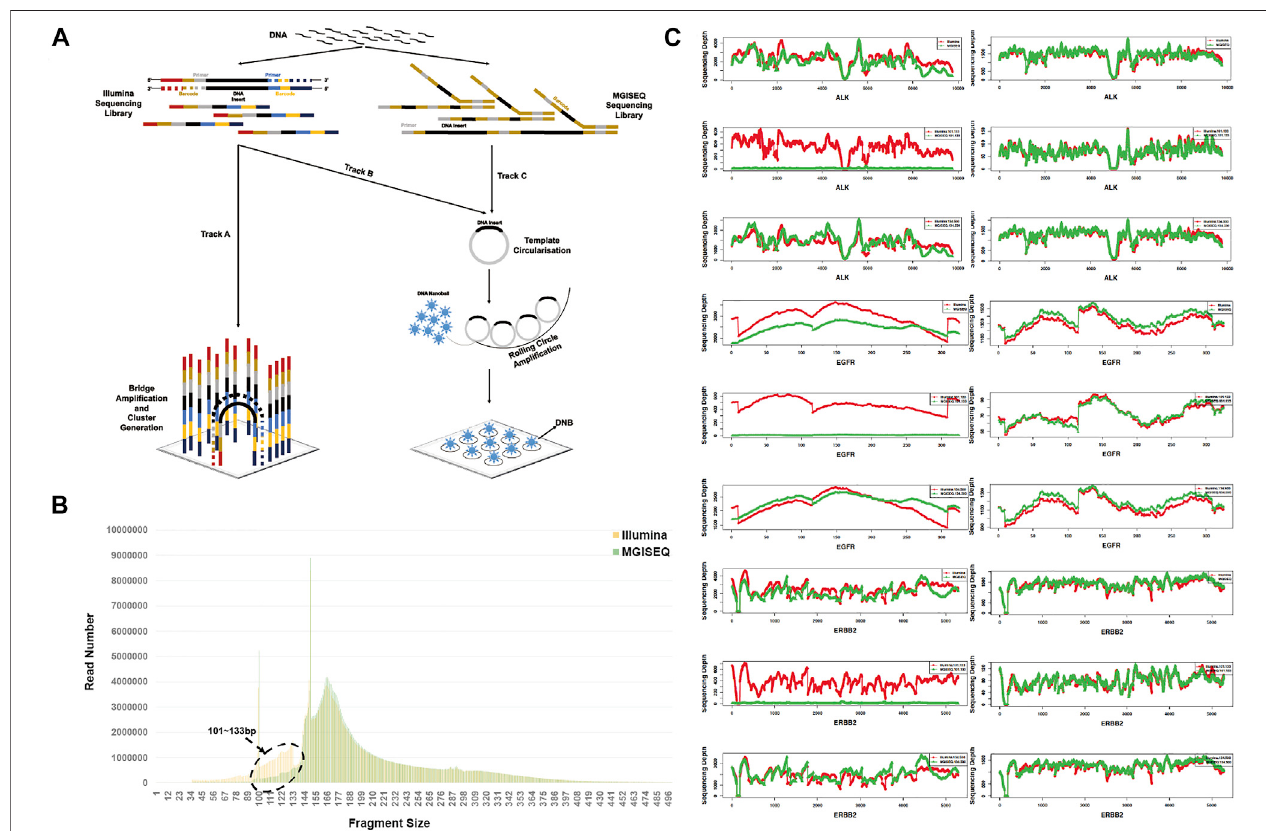
FIGURE 3 | The Insert Fragment Size Analysis of Illumina-based Capture Library On the Illumina and MGISEQ-2000 Platforms. (A) The principles of Illumina and MGISEQ sequencers. Track A represents the Illumina library combined with bridge PCR ampli fi cation of the Illumina platform. Track B represents the Illumina library combined with DNA circularization for DNB of the MGISEQ-2000 platform. Track C represents the MGISEQ library combined with DNA circularization for DNB of the MGISEQ-2000 platform. (B) Compared with the Illumina platform data, the MGISEQ-2000 platform data had a signi fi cant loss of 101 – 133 bp fragments. (C) Statistical analysis of sequencing depth distribution in ALK, EGFR and ERBB2 with one sample. Sequencing depth distribution of 101 – 133 bp (left panel) and 134 – 500 bp (right panel) in ALK (top), EGFR (middle), and ERRBB2 (bottom). In each fi gure panel, the top panel shows the sample total sequencing depth distribution, themiddlepanelshowsthesequencing depthof101 – 133 bpfragmentsize,and thebottompanelshowsthe134 – 500 bpfragmentsizesequencing depthdistribution.